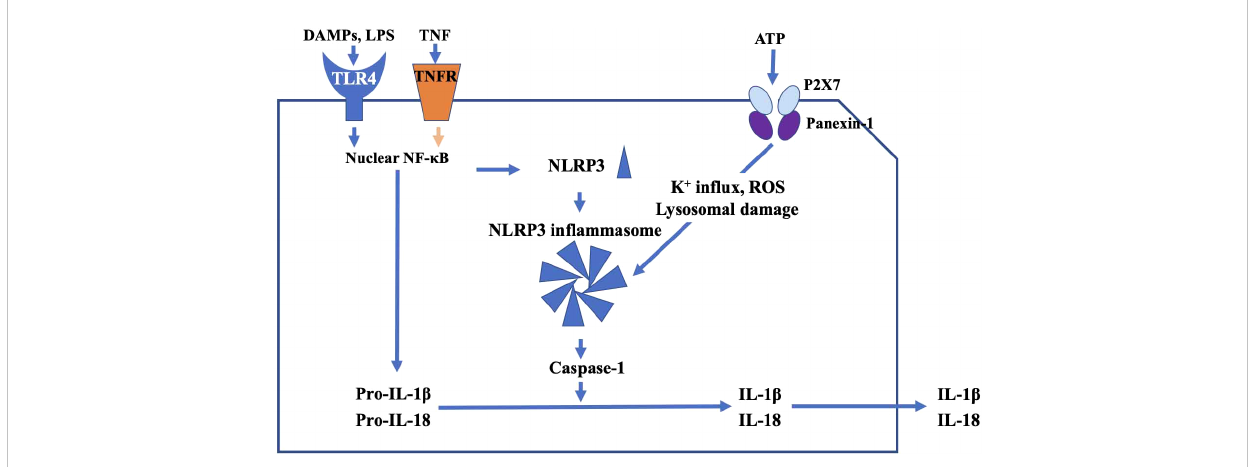
FIGURE 2 The main pathway of TLR4-mediated in fl ammatory response. DAMPs and TNF activate nuclear NF- k B signaling and generate NLRP3. Pro-IL-1 b , adaptor proteins, and NLRP3 assemble into a characteristic heptameric structure and form the NLRP3 in fl ammasome. NLRP3 in fl ammasome activates caspase-1, and produces the proin fl ammatory cytokines IL-1 b and IL-18, which in turn may damage RGCs. ATP promotes increase of intracellular K+ ef fl ux, generation of reactive oxygen species (ROS), and lysosomal damage via the P2X7 receptor, resulting in activation of the NLRP3 in fl